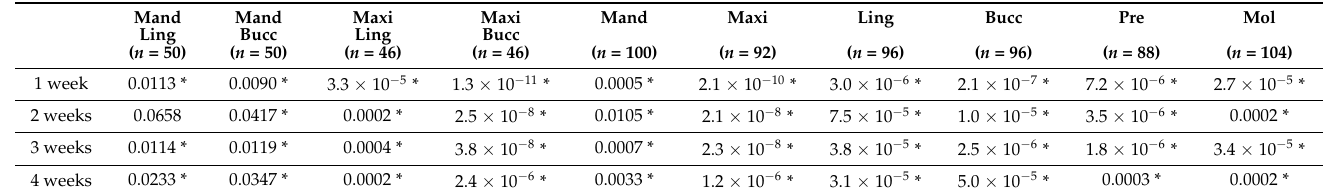
Table 7. p -values comparing the adhesion ratio of Bio Coat Ca and Hybrid Coat II in each